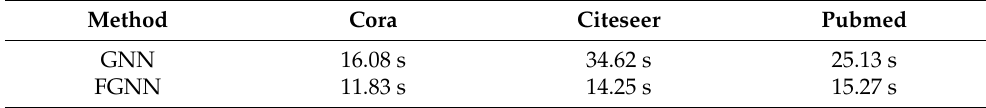
Table 6. Convergence time of GNN and FGNN on citation network